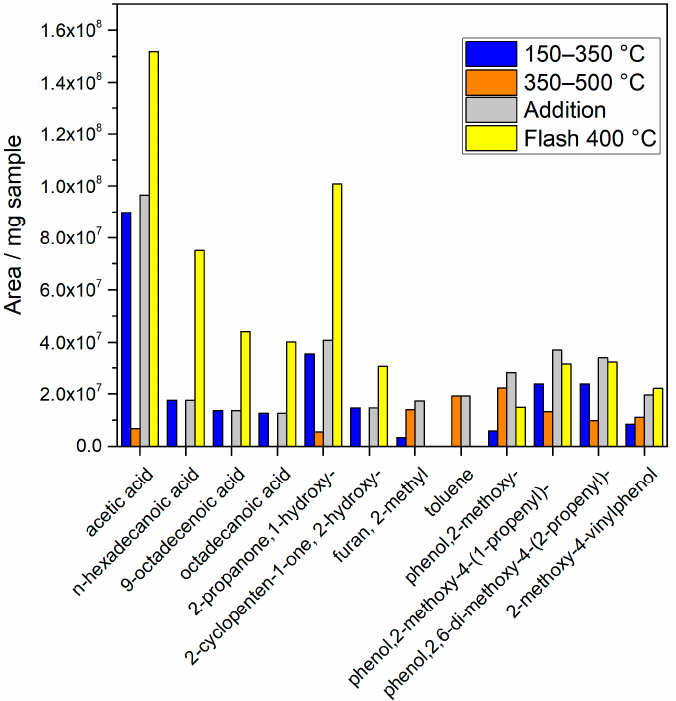
Figure 5. Comparison of area/mg sample values of different pyrolytic compounds under different conditions.